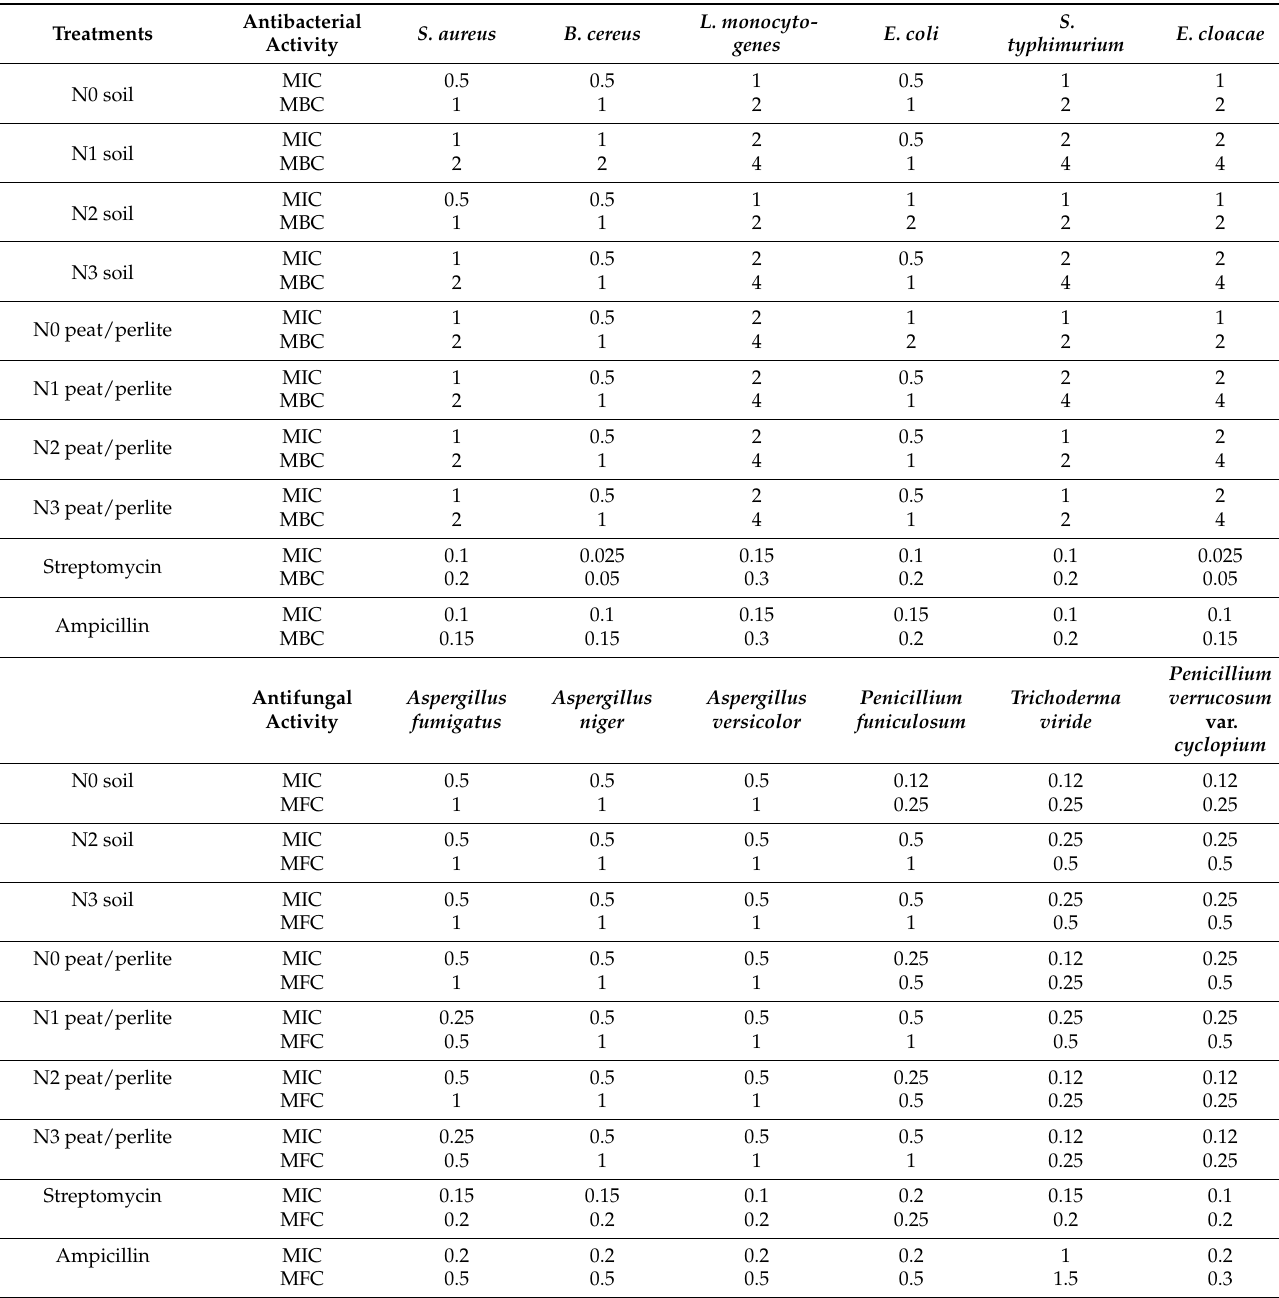
Table 6. Antibacterial activity (MIC and MBC mg/mL) and antifungal activity (MIC and MFC mg/mL) of Centaurea raphanina spp. mixta plants in relation to nitrogen fertilization and growth substrate (mean ± SD).